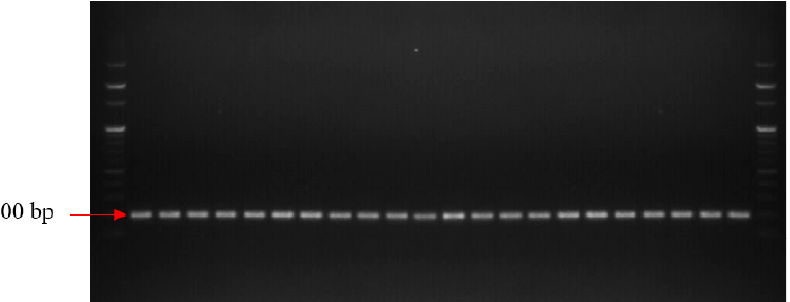
Figure 1. Gel electrophoresis image showing amplification of XOP-Q in all 22 isolates of Xap.